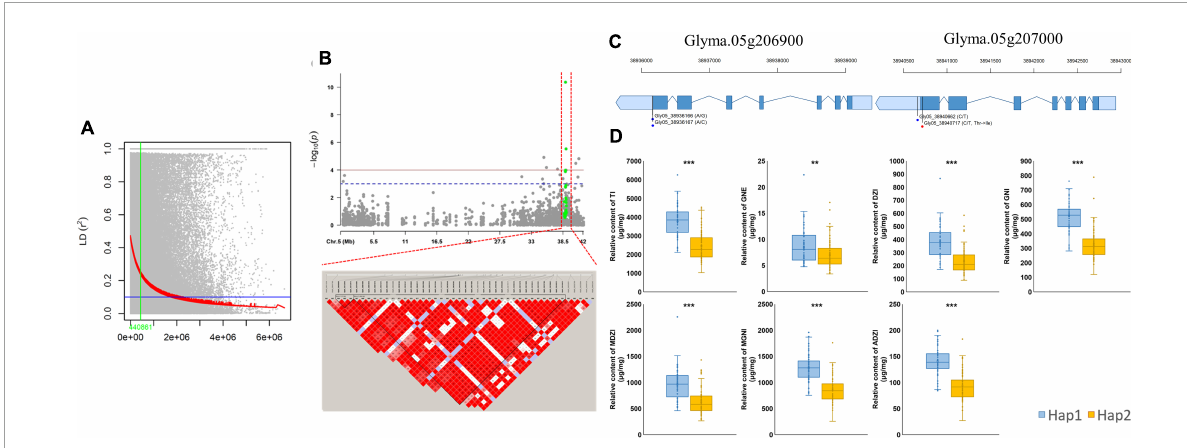
FIGURE5 Linkage disequilibrium (LD) analysis of Gm05:38940662 ( GmGSTT1 ) and variations in isoflavone contents between haplotypes. (A) Genome-wide average LD decay (R2) of MDP; (B) association mapping for Gm05:38940662 and LD analysis based on isoflavone contents; (C) gene models of GmGSTT1 (Glyma.05g206900 and Glyma.05g207000); (D) isoflavone contents in different haplotypes.